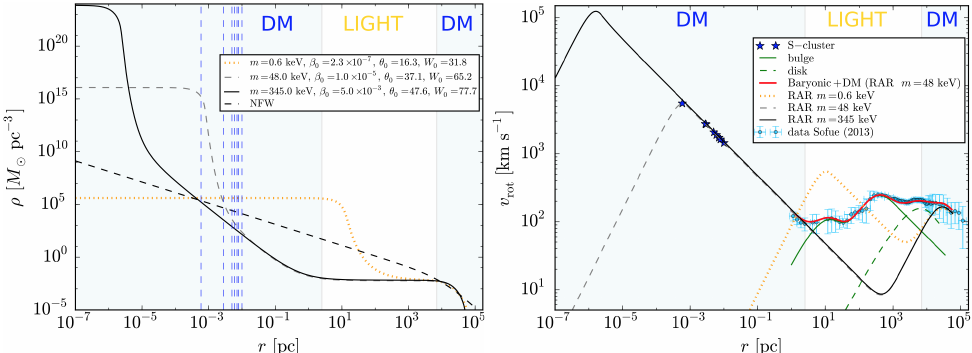
Figure 1. DM density profiles ( left ) and rotation curves ( right ), from 10 − 7 pc to 10 5 pc, for three representative fermion masses mc 2 = 0.6, 48, and 345 keV. The vertical dashed blue lines in the left plot indicate the position of the S-cluster stars [47], and the dashed black curve represents the NFW density profile obtained in Sofue [45]. Reprinted from [32], Copyright (2018), with permission from